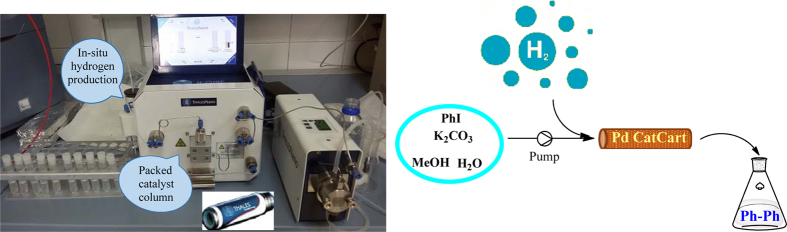
Schematic depiction of the H-Cube mini and continuous flow set up for a reductive homocoupling reaction of phenyl iodide.